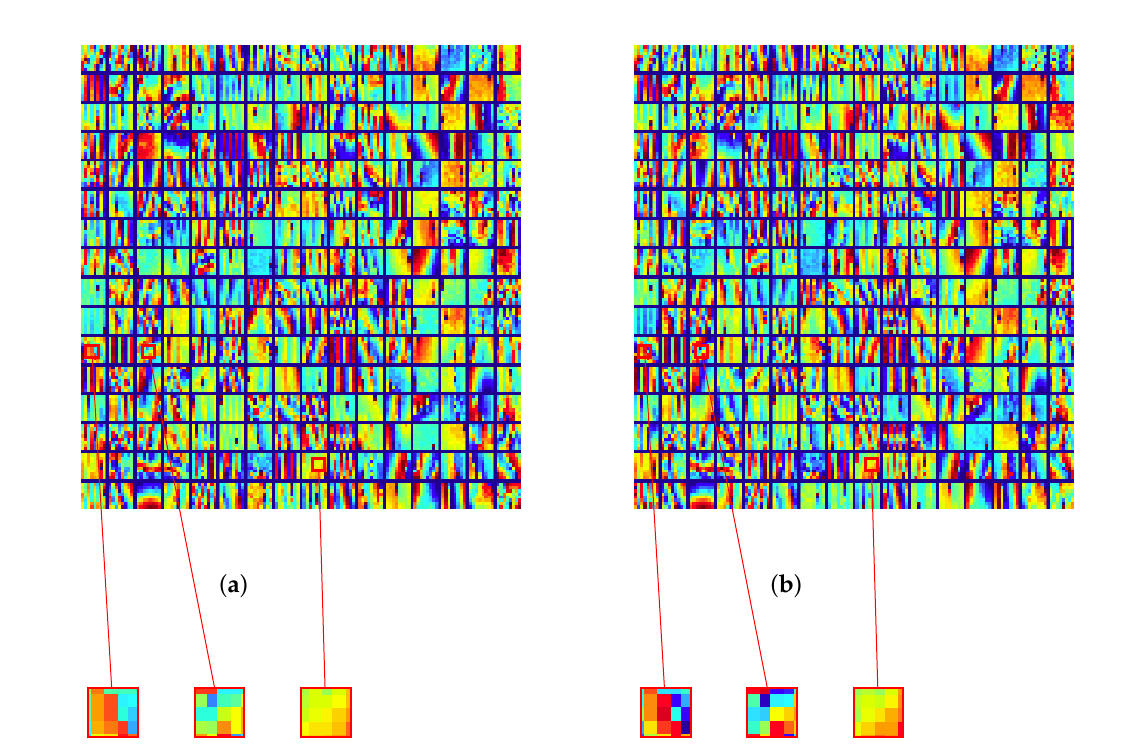
,256 , for ERS data of Rome (Italy) patched into Figure 8. Final update of dictionary, D ( k ) , k = 1 { · · · } 16 16 patches, 64 64 pixels each. ( a ) K-SVD and ( b ) ProK-SVD. Some blocks are highlighted to × × show the effects of